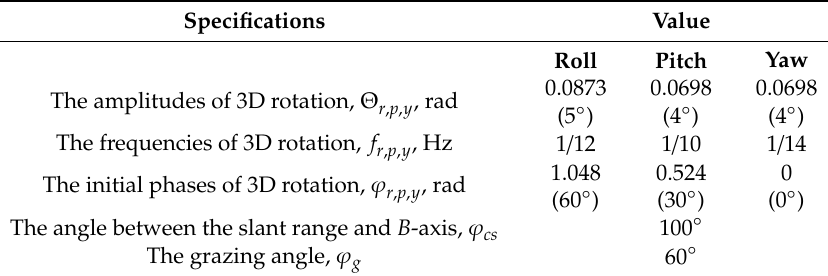
Table A1. Parameters of the rotational